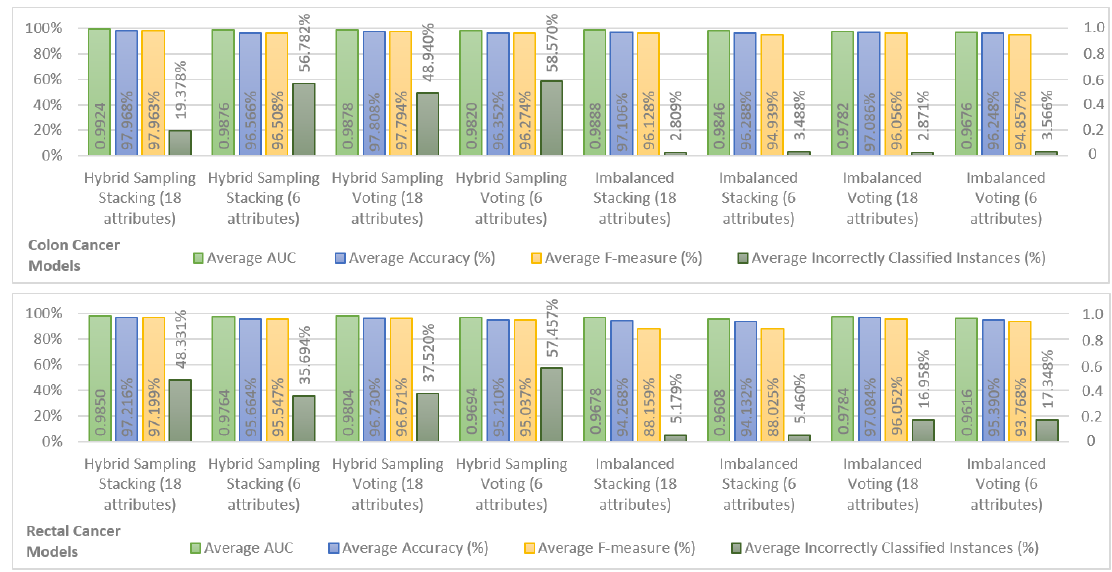
Figure 1. Survivability models for colon and rectal cancer for both balanced and imbalanced datasets.